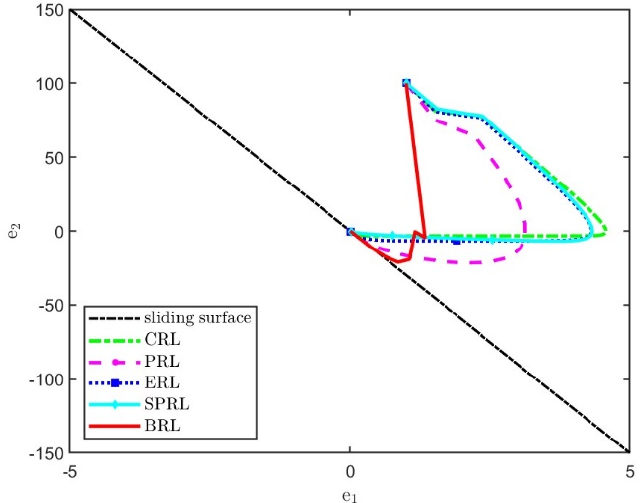
Figure 4. Sliding mode motions for different reaching laws under step signals.